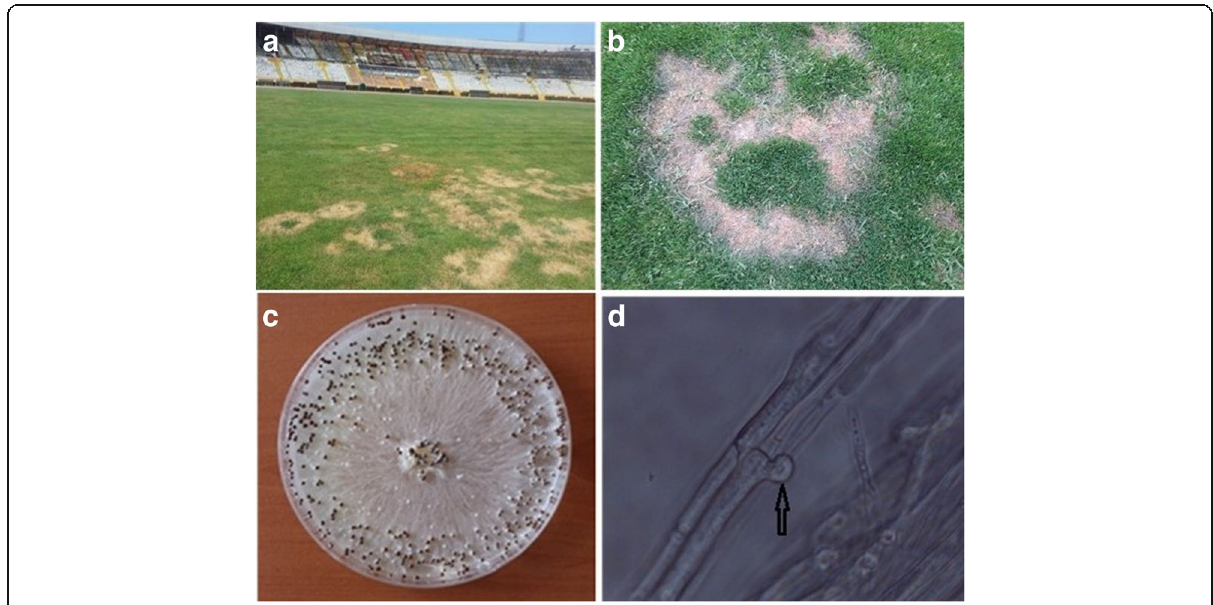
Fig. 1 General view of disease symptoms on turfgrass areas ( a from afar, b close view). Colonial view on PDA ( c ). Clamp connection on hypha ( d ) of Sclerotium